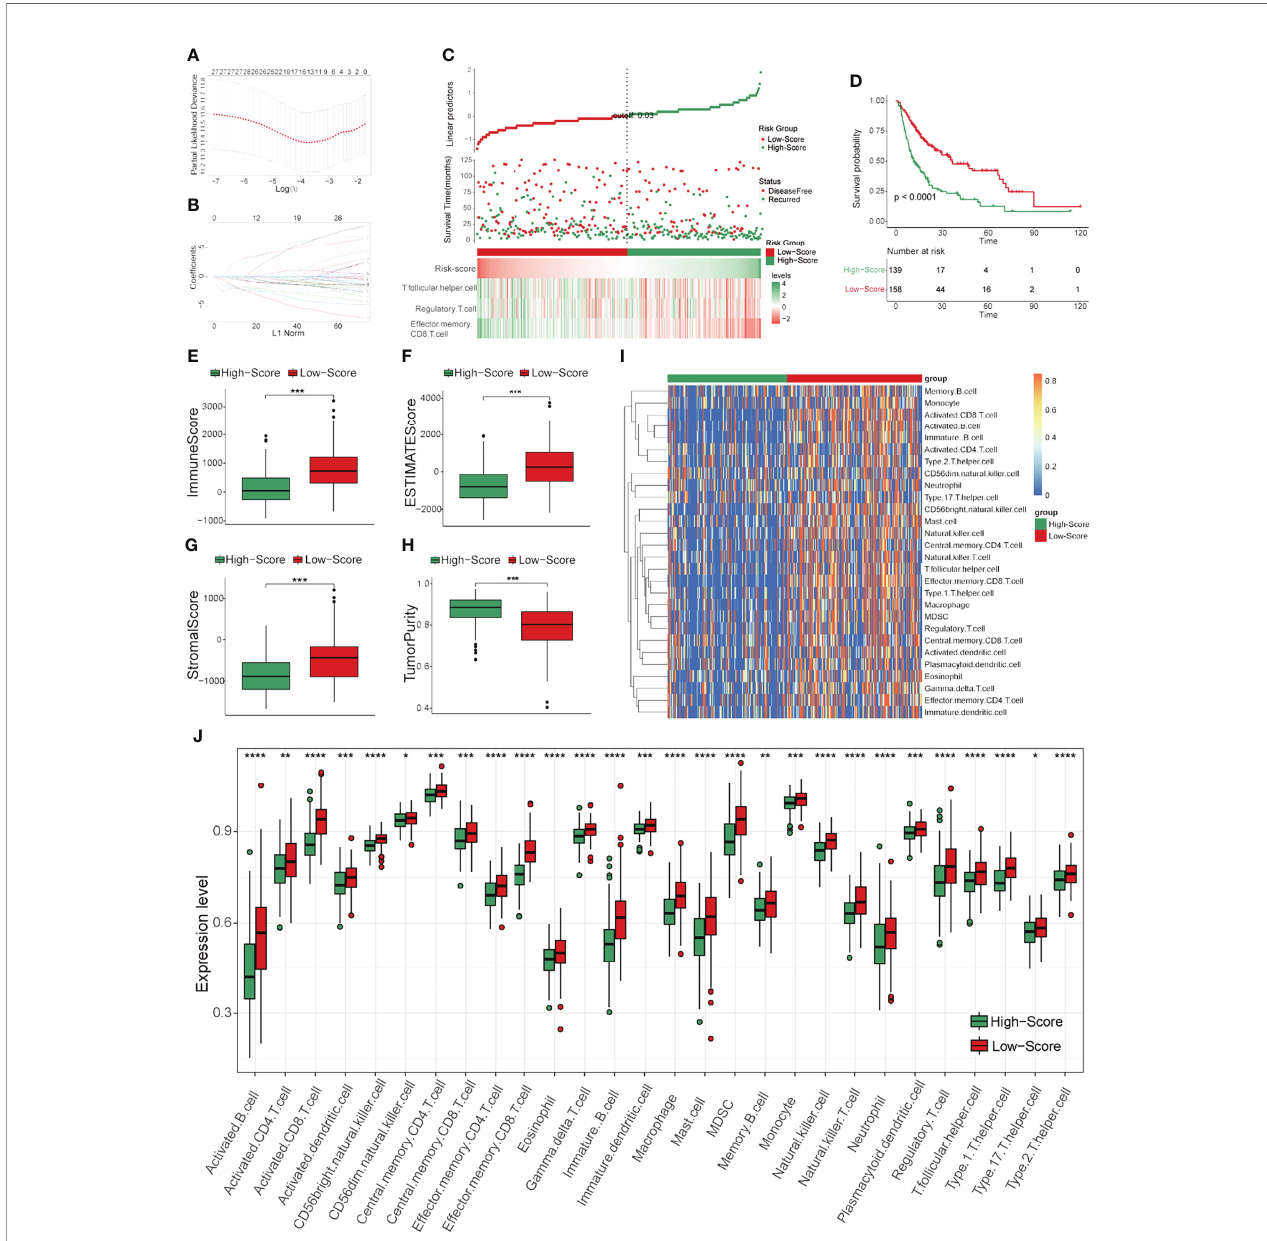
FIGURE 2 | Construction and evaluation of the TCRS in the training cohort. (A, B) Cv fi t and fi t plots of LASSO screen. (C) Survival status and abundances of effector memory CD8 T cells, regulatory T cells and follicular helper T cells between the high- and low-score groups. (D) Kaplan-Meier curve for the two groups in the training cohort. (E – H) The expression levels of the immune score (E) , ESTIMATE score (F) , stromal score (G) and tumor purity (H) between the two groups. (I, J) The expression levels of 28 immune cells for the two groups visualized by heatmap (I) or boxplot (J) . *p < 0.05, **p < 0.01, ***p < 0.001, ****p <